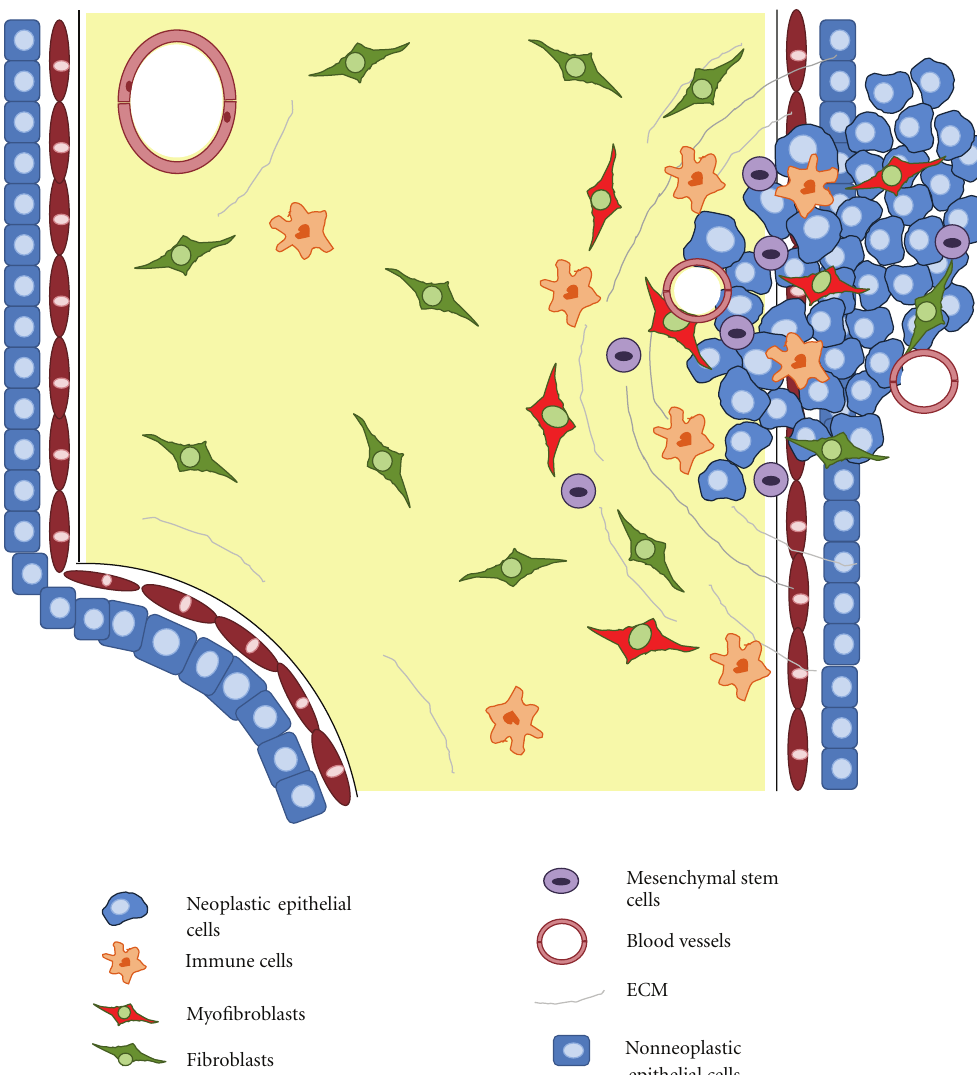
Figure 1: Intra- and extratumoral microenvironments and cellular components of these compartments. Cell types present in the extratu- moral and intratumoral microenvironment are similar and include fibroblasts, immune cells, endothelial cells, and mesenchymal stem cells. Abundance and signaling of these cells vary widely between and within individuals with